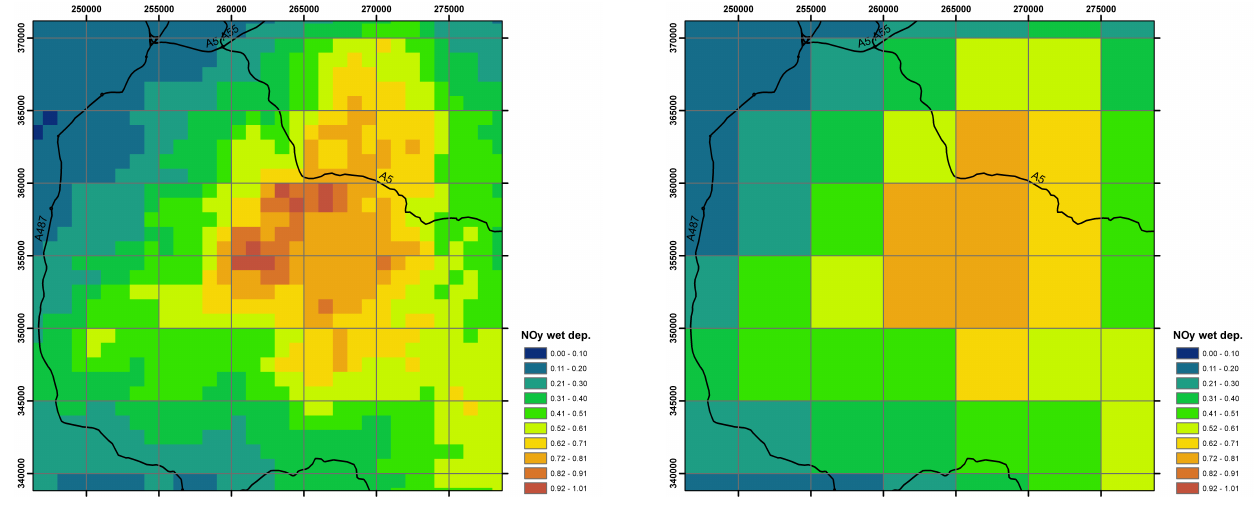
Fig. 4a. NO y wet deposition in Snowdonia (keqha − 1 ) with 1km grid resolution.